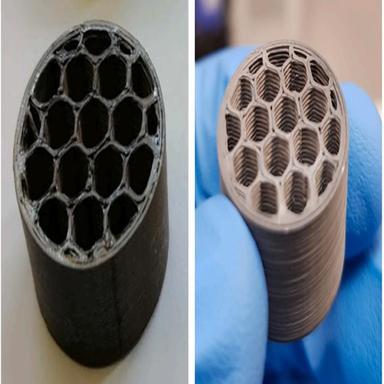
Images of catalyst MnOx-1200–02 (left) and Pt-1200–01 (right) after calcination and prior to activity testing.